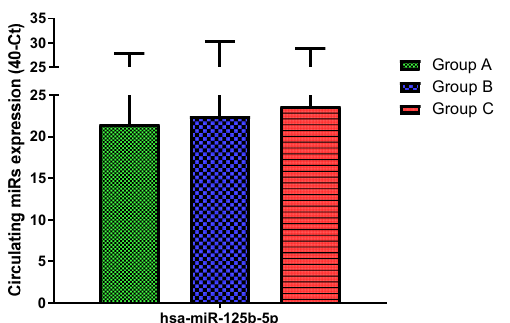
Figure 8. Serum levels of hsa-miR-125b-5p in HNW (Group A), MANW (Group B) and HNAO (Group C). Results were shown as means ± SD. The statistical tests used in these analyses were one- way analysis of variance using Kruskal–Wallis test followed by Dunn’s Multiple Comparison Test.